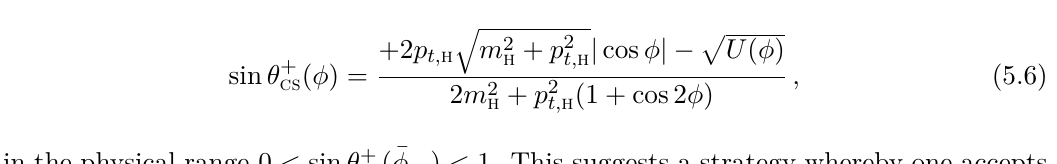
Algorithm 1 Hardness Compensating Boost-Invariant (CBI whether an event with a two-body decay should be accepted. It takes a Born transverse- momentum threshold p decay products.